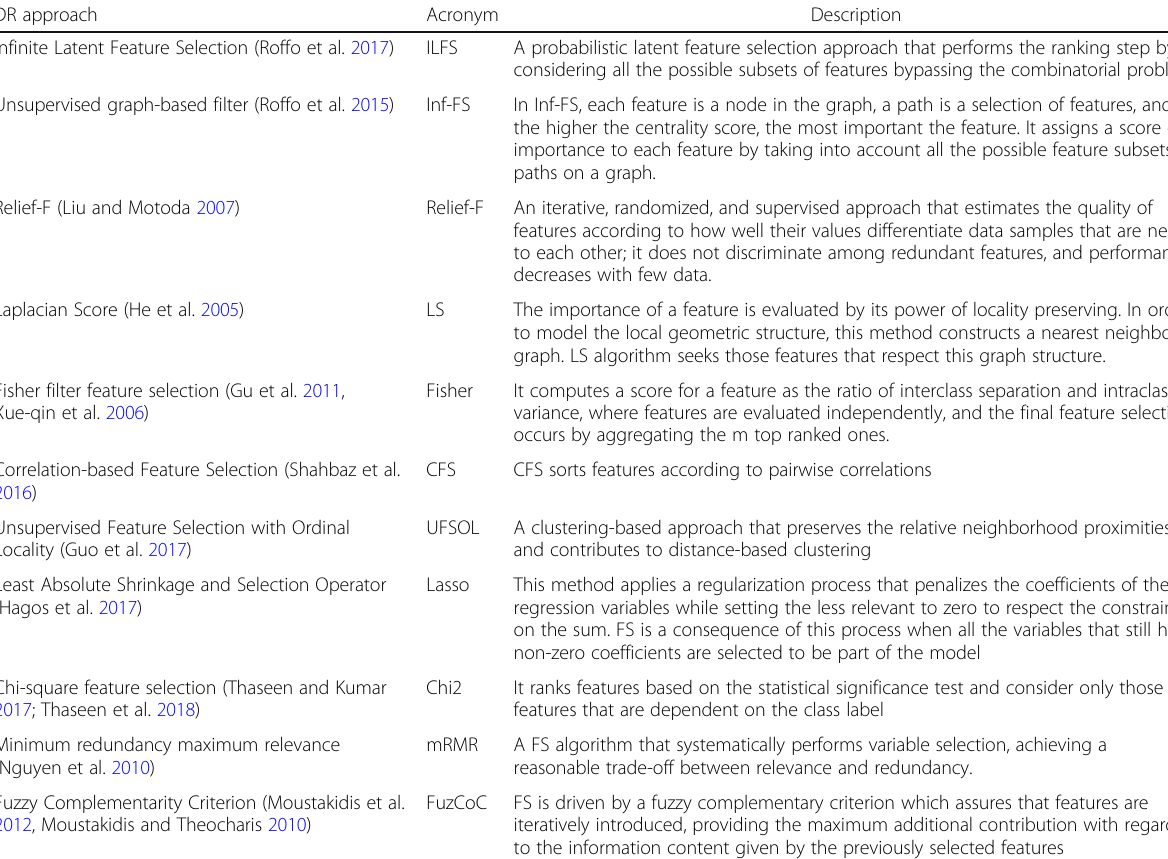
Table 3 Well known DR methods from the literature that were compared with the proposed